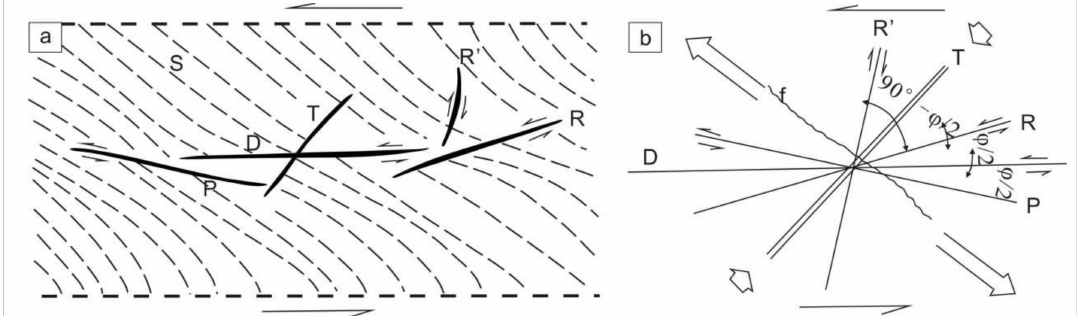
Figure 7. Shear zone features of the Sn ore-forming system [49,50] (modified after Aydin and Page, 1984; Sylvester, 1988). ( a ) Ore-bearing veins. ( b ) Shear fracture system. T = tension fissure formed along the strain ellipsoid (X–Z plane); R = Riedel shear; R’ = conjugate Riedel shear; S = foliation; D = principal shear fracture (i.e., parallel to the shear zone boundary); f = fold surface; P = co-shear fracture; ϕ = angle of internal